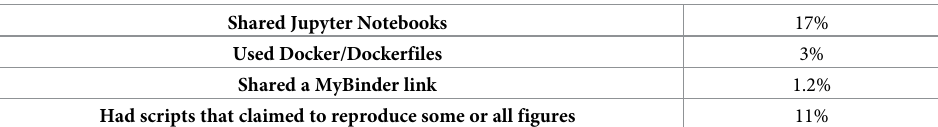
Table 2. Reproducibility tools used by percentage.